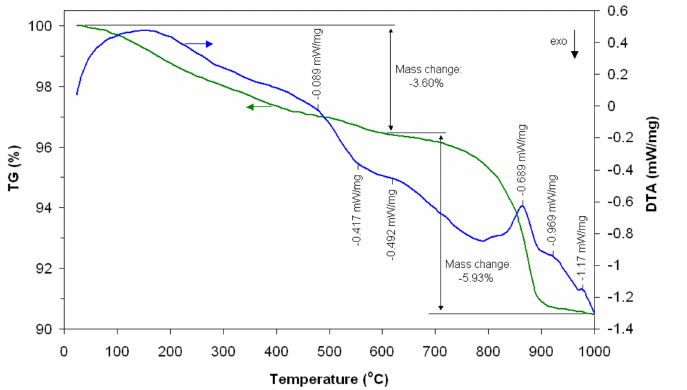
Figure 1. TG-DTA curves of gadolinium aluminate (before heat